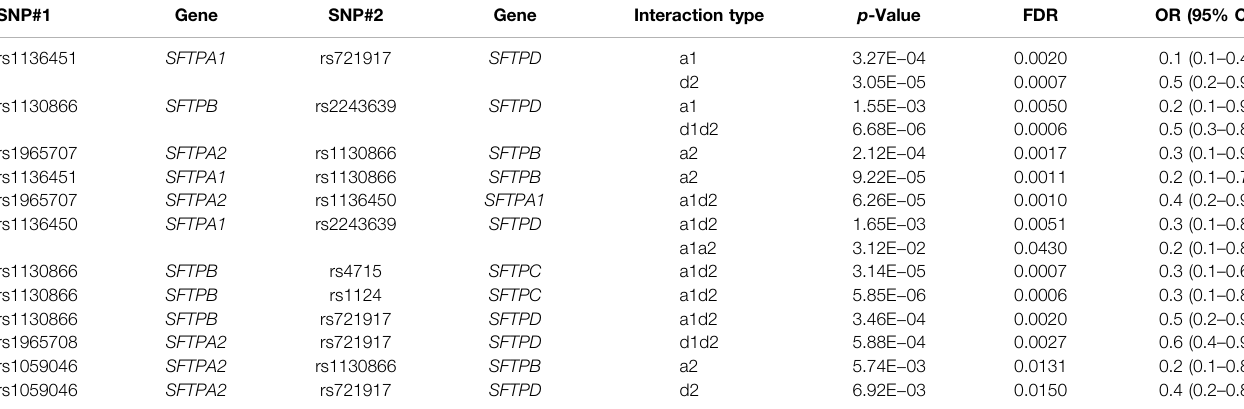
TABLE 4 | Associations of SP gene SNP interactions with persistent respiratory morbidity (PRM) at 6 months in a two-SNP model after adjusting for covariates (age, sex, race, and weight). SNP#1